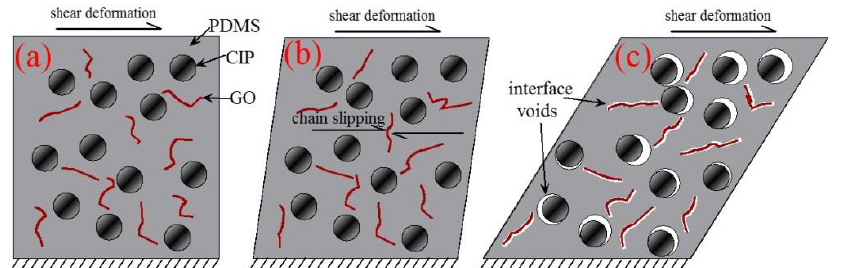
Figure 8. Schematic of the microstructural deformation mechanisms of GO-filled MREs under shear deformation: ( a ) initial state; ( b ) small shear strain; and ( c ) large shear deformation.